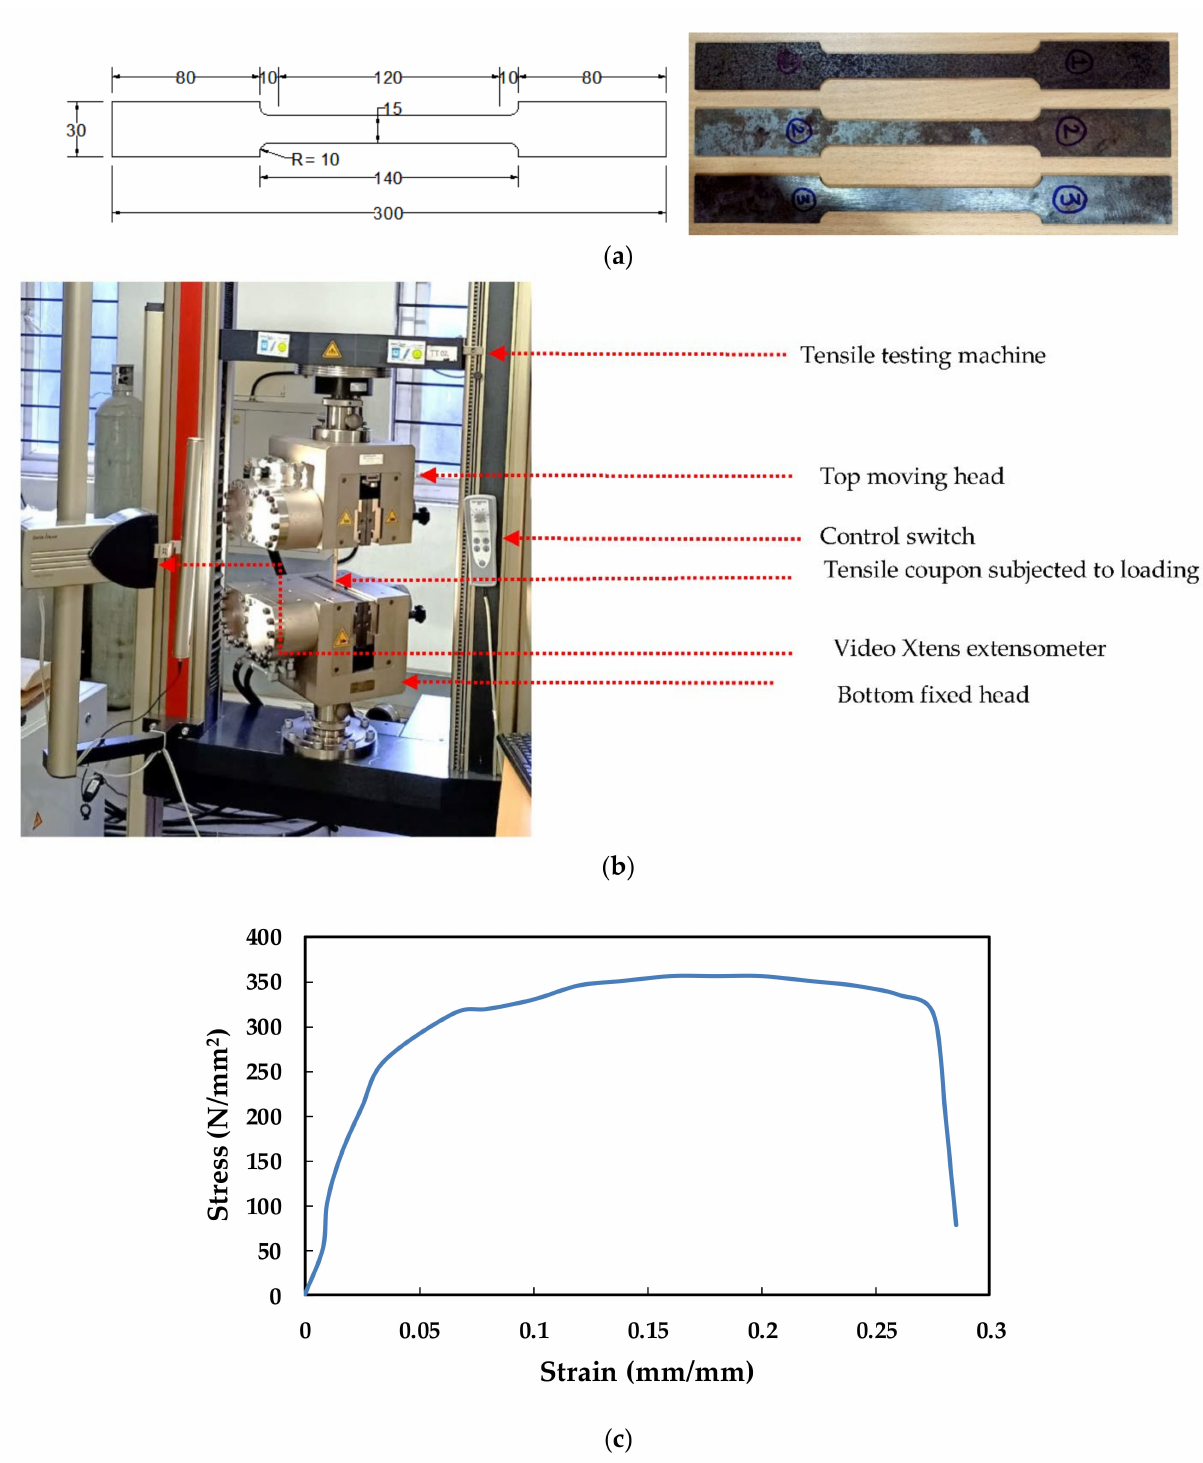
Figure 6. Details of the tensile coupon tests. ( a ) Coupon size details. ( b ) Zwick/Roell Z100 kN (Ulm, Germany) electromechanical testing machine. ( c ) Full stress-strain curve of the CFS channel sections used in this research. (all dimensions in